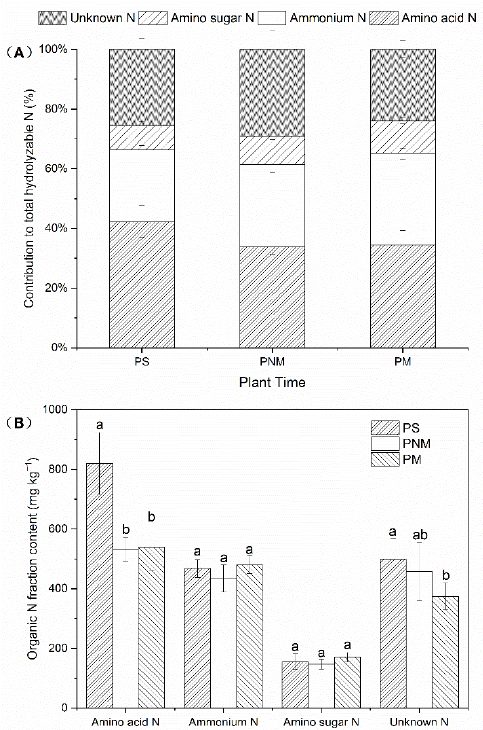
Figure 2. The proportion ( A ) and content ( B ) of different organic nitrogen fractions for the paddy field, P. plantation without mulching and P. plantation with mulching sites. PS, rice paddy soil; PNM, Phyllostachys praecox plantation without mulching; PM, P. praecox plantation with mulching. Bars are the mean ± standard error ( n = 3). Different lower-case letters indicate significant differences according to Duncan’s test at the 0.05 level.